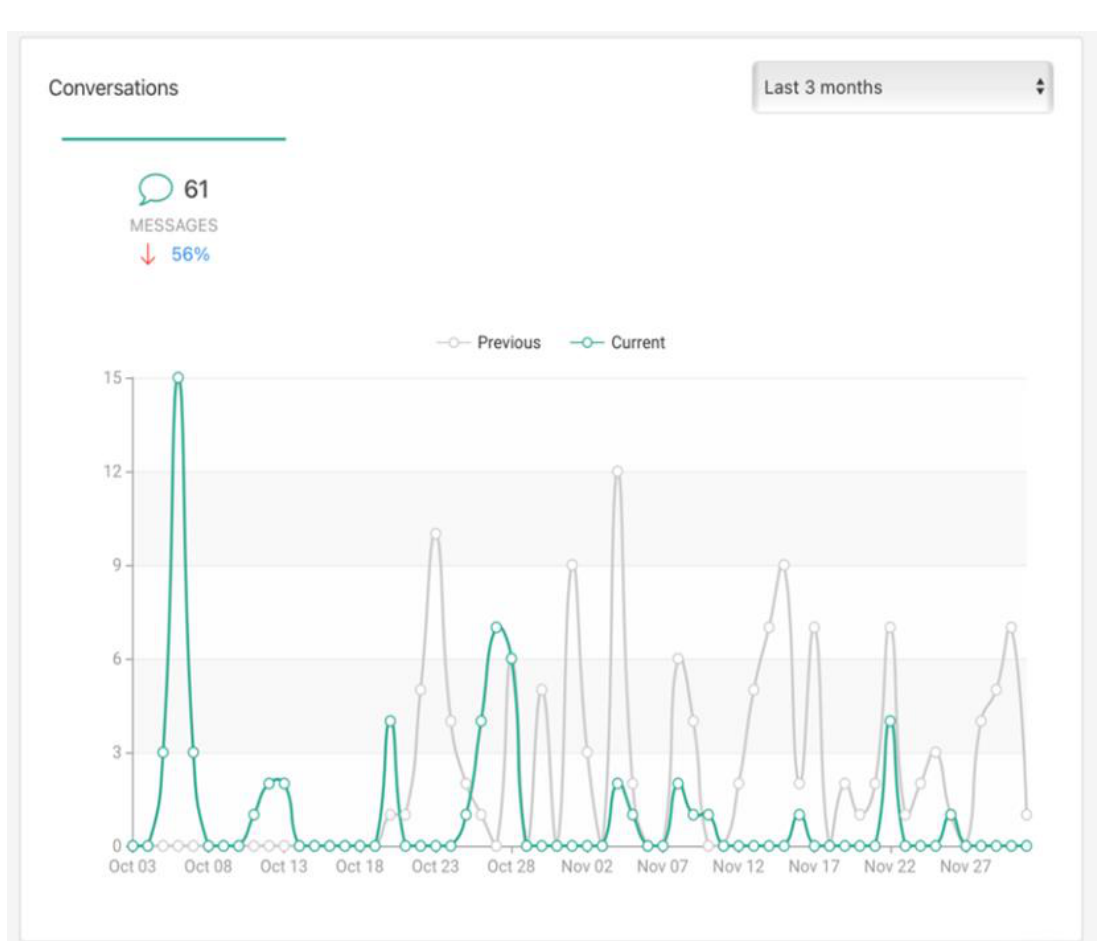
Figure 3. Screenshot of sample data monitoring of peer contact. “Current” reflects the most recent time period, and “Previous” the same time interval prior to the most recent measurement period.